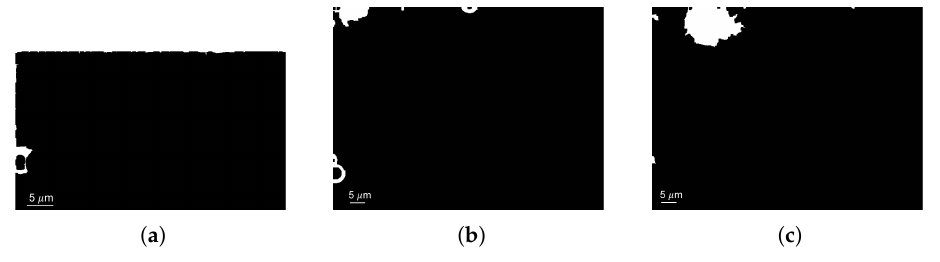
Figure 14. Silhouettes of the objects on image boundaries obtained by subtracting Figure 13 from the eroded bright field images shown in Figure 12: ( a ) I iw